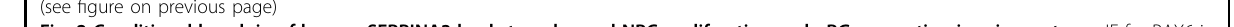
Fig. 2 Conditional knock-in of human SERPINA3 leads to enhanced NPC proliferation and oRG generation in mice cortex. a IF for PAX6 in E15.5 WT and cKI f/ + mice. The dashed white lines represent the border of PAX6 layer in VZ/SVZ. Arrow, PAX6 + cells in expanded SVZ. Scale bar, 50 μ m. b Quanti fi cation for the percentage of PAX6 + cells in the expanded SVZ (WT n = 3; cKI f/ + n = 4). c Quanti fi cation for the thickness of PAX6 + cells in VZ/SVZ (WT n = 3; cKI f/ + n = 4). d IF for SOX2 and TBR2 in E15.5 WT and cKI f/ + mice. The dashed white lines represent the border between VZ and SVZ. Arrow, SOX2 + TBR2 − cells in expanded SVZ. Scale bars, 20 μ m (left) and 10 μ m (right). e Quanti fi cation for the percentage of SOX2 + cells in the expanded SVZ (WT n = 3; cKI f/ + n = 4). f Quanti fi cation for the number of SOX2 + TBR2 − cells in the expanded SVZ ( n = 4). g Quanti fi cation for the percentage of TBR2 + cells in the expanded SVZ ( n = 4). h IF for SOX2 and P-VIM in E15.5 WT and cKI f/ + mice. Arrow, SOX2 + P-VIM + cells. Scale bar, 20 μ m. i Quanti fi cation for the percentage of SOX2 + P-VIM + cells in the expanded SVZ (WT n = 3; cKI f/ + n = 4). j IF for HOPX in the expanded SVZ of E15.5 WT and cKI f/ + mice. Images 1 and 2 show the expanded SVZ region. Arrow, HOPX + cells. Scale bars, 50 μ m (left) and 10 μ m (right). k Quanti fi cation for the percentage of HOPX + cells in the expanded SVZ (WT n = 3; cKI f/ + n = 4). l IF for PH3 in E15.5 WT and cKI f/ + mice. The dashed white lines represent the border between Apical and Basal. Scale bar, 20 μ m. m Quanti fi cation for the percentage of PH3 + cells in basal cortex (WT n = 3; cKI f/ + n = 4). n IF for BrdU in E15.5 WT and cKI f/ + mice. The dashed white lines represent the border between Apical and Basal. Scale bar, 20 μ m. o Quanti fi cation for the percentage of BrdU + cells in basal cortex (WT n = 3; cKI f/ + n = 4). Two-tail unpaired t -test is used to analyze the data. n.s. no signi fi cant difference; P < 0.05 (*), P < 0.01 (**), P < 0.001